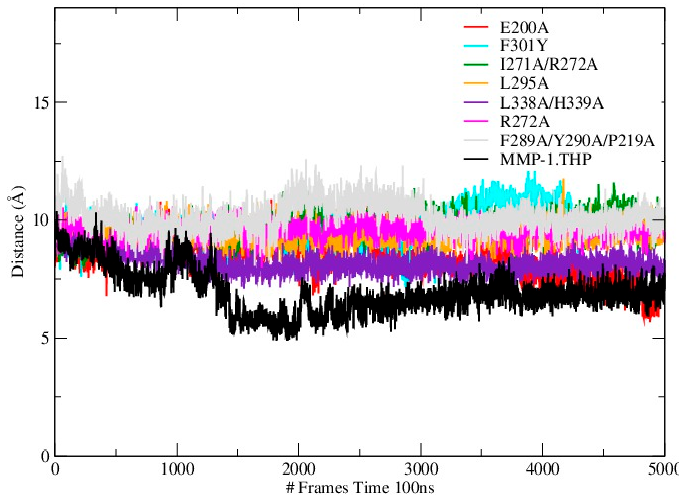
Figure 4. Time evolution of the distance between the scissile bond G775-L776 and Zn 2+ in WT MMP-1•THP and the mutants.